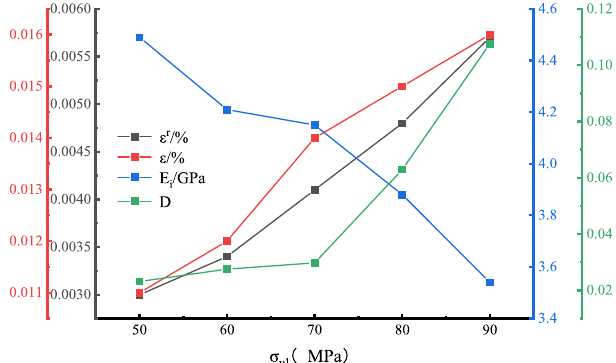
Figure 6. Variation curve of reload deformation characteristics with unloading point.